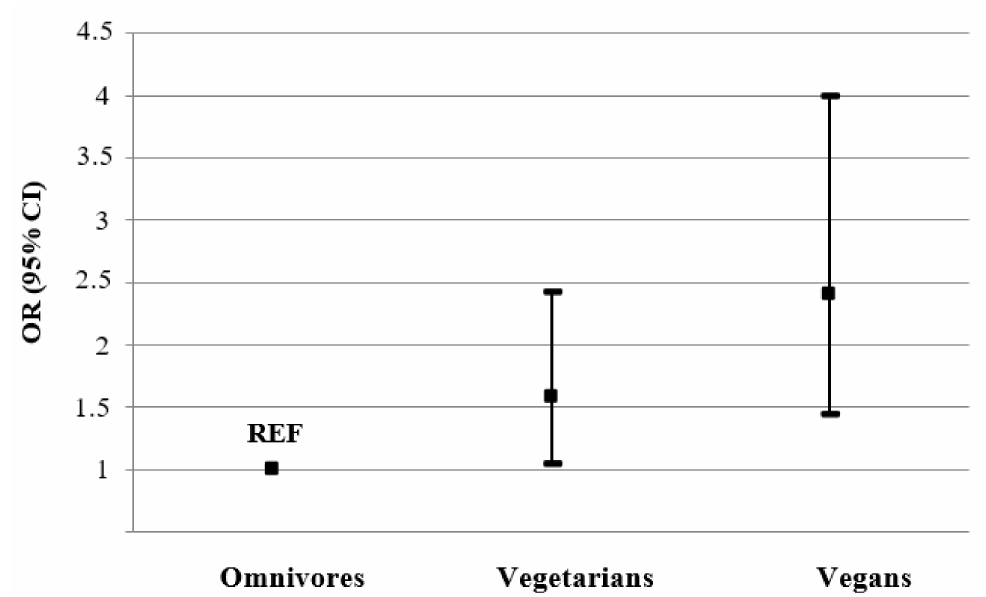
Figure 4. The likelihood of good well-being by the type of diet followed in women. The presented results were adjusted for age, place of living, education, marital status, physical activity, BMI, health status, cigarette smoking, sleeping time, traumatic event, and stress level. Abbreviations: OR—odds ratio; CI—confidence interval; REF—reference